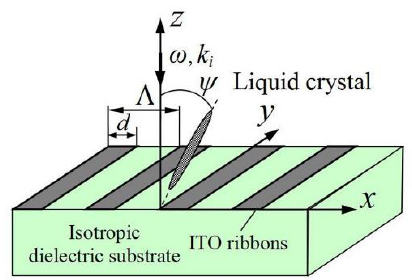
Figure 1. Schematic showing the electromagnetic wave with the wave vector k i incident from the LC layer on the ITO grating located on the isotropic dielectric. Λ is the grating spacing and d is the width of the ITO ribbons. 62